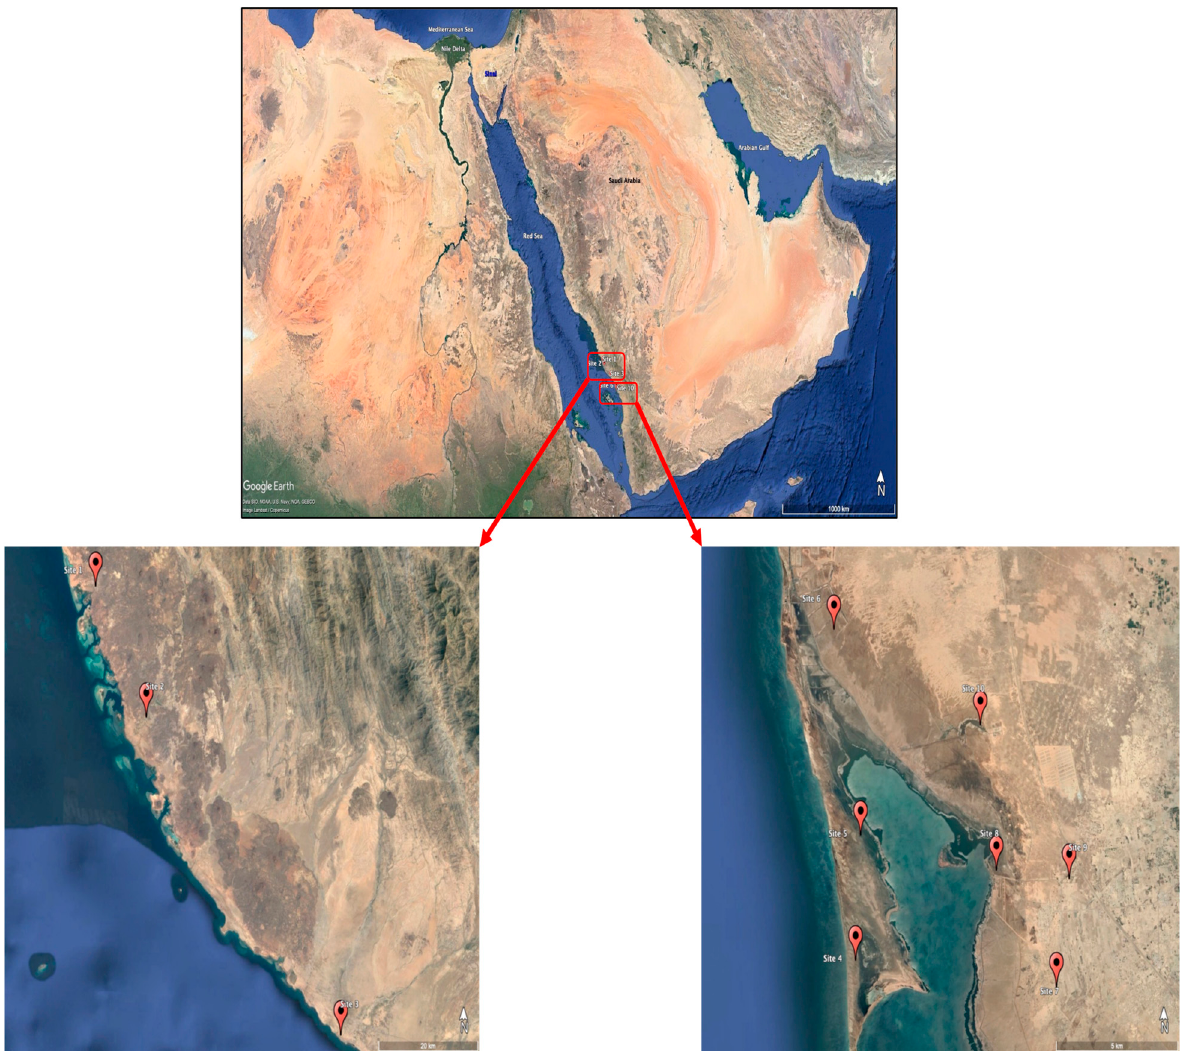
Figure 1. Satellite images of the study area indicating the ten sampling sites represent ten sabkhas.